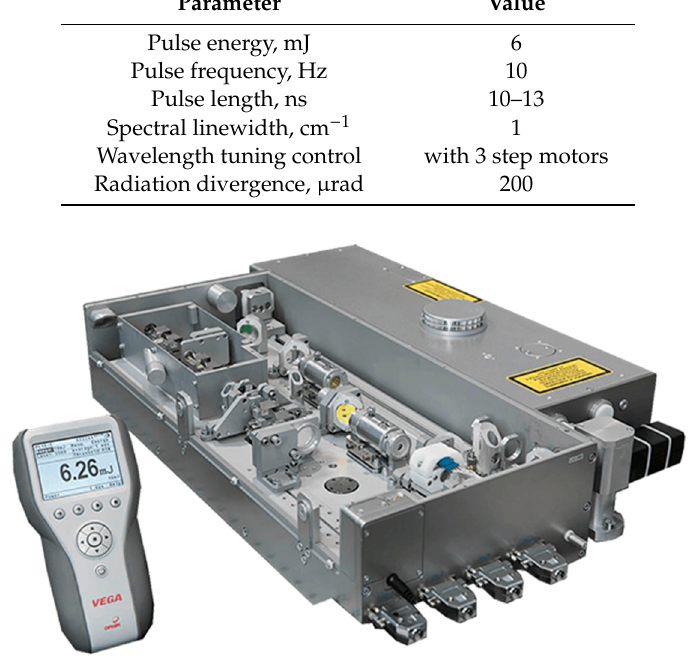
Table 1. Laser source parameters.